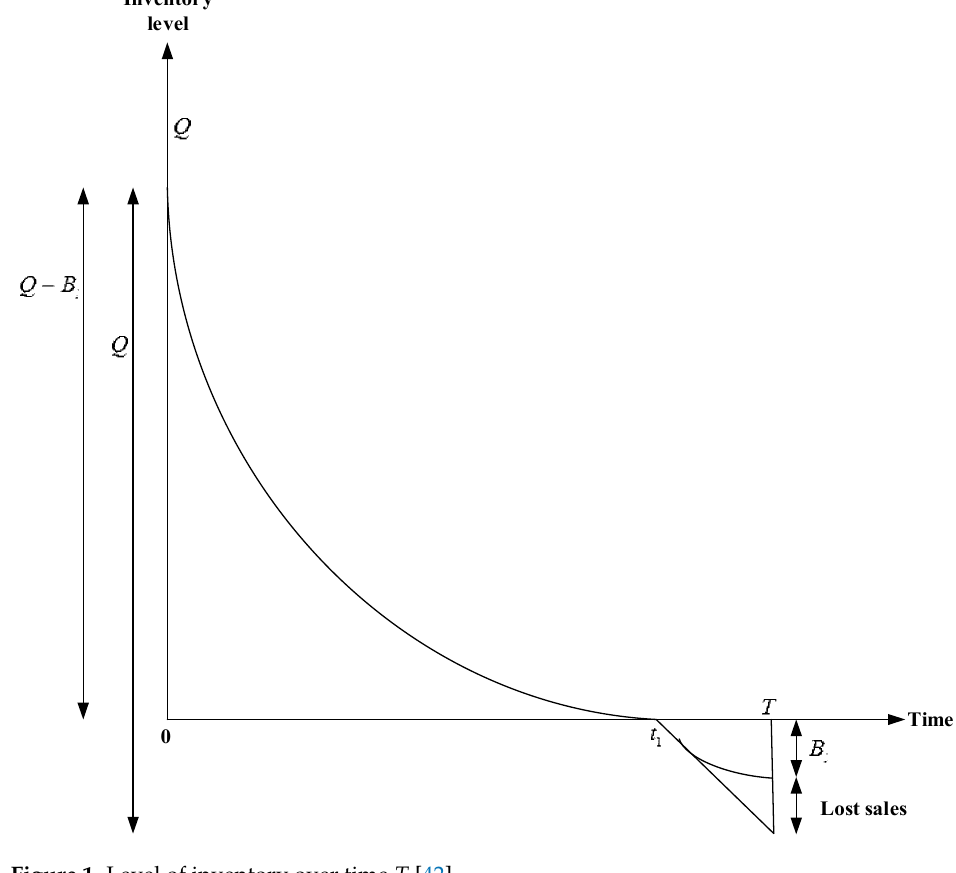
Figure 1. Level of inventory over time T [42].